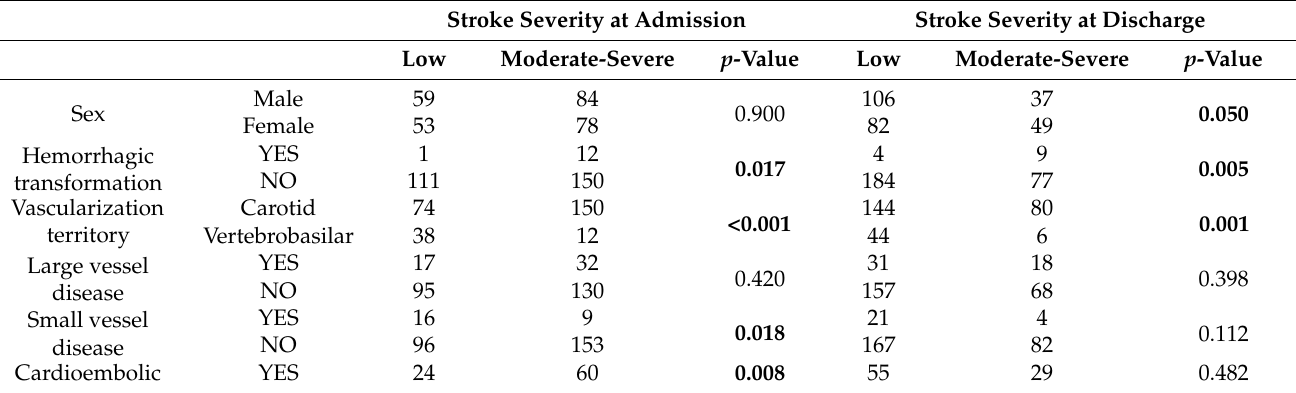
Table 6. Crosstabs between stroke severity and clinical